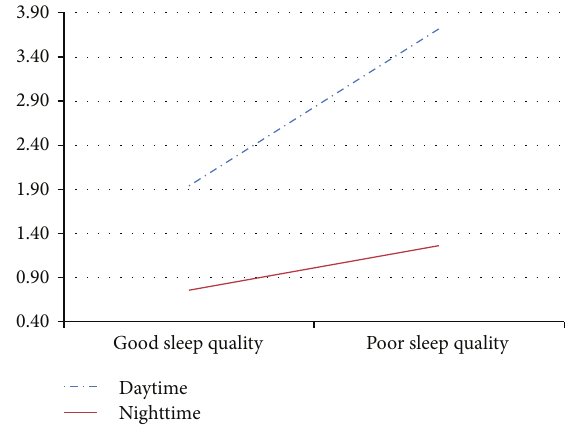
Figure 1: Interaction of time of day by valence for number of different response categories. Scores are based on the total number of responses participants